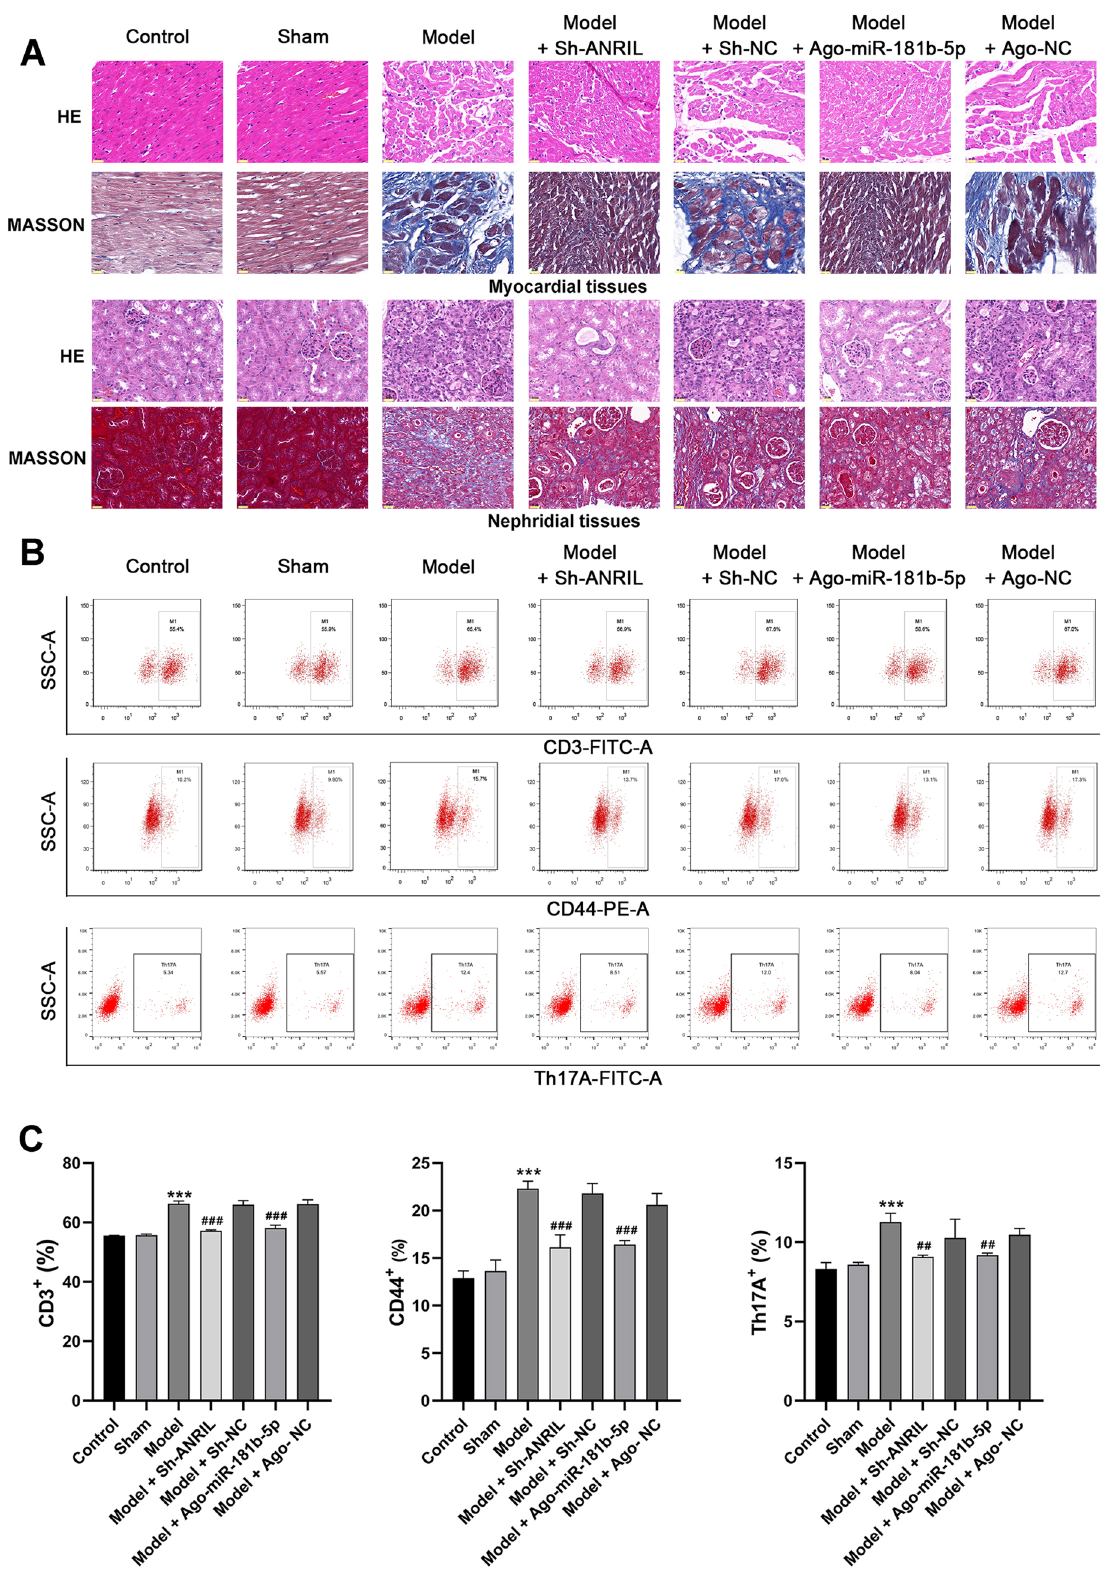
Figure 6. The effects of ANRIL silencing or miR-181b-5p overexpression on pathological changes and T cell activation in UC mice ( A ) HE and Masson staining of myocardial and nephridial tissues, scale bar = 20 μm; ( B ) flow cytometry of T cell markers (CD3, CD44, and Th17A); ( C ) quantifying of cells positive for CD3, CD44, and Th17A. ***P < 0.001 vs. control; ## P < 0.01, ### P < 0.001 vs. model. Data was analyzed using t test or one-way analysis of variance (ANOVA) followed by Tukey’s